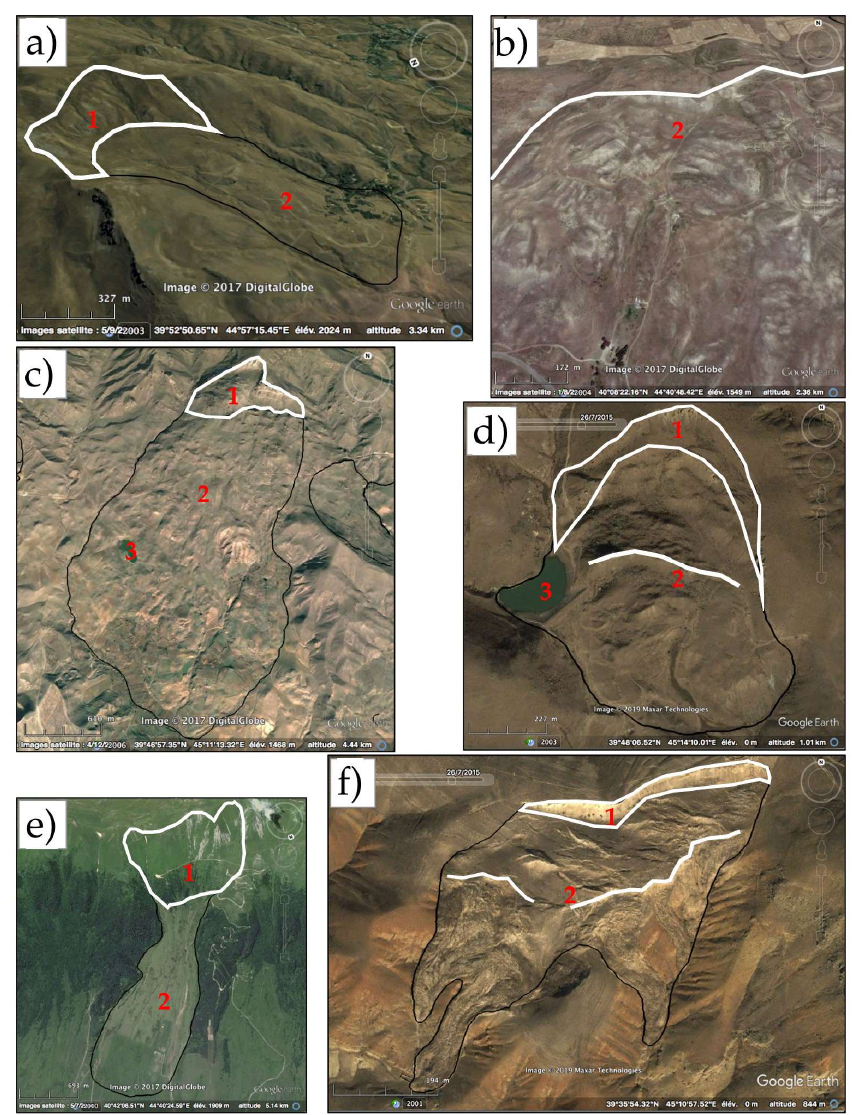
Figure 6. Examples of landslides identified in the present Matossian catalogue (based on data provided by DigitalGlobe and Google Earth ® ) representative of the criteria used to identify landslides. Landslide features are indicated as: 1, main scarp (outlined in white); 2, main landslide body (outlined in black, with secondary internal scarps indicated by white lines); and 3, lakes. ( a ) The Lanjanist landslide, showing a change of surface curvature. The landslide length (measured from the upper part of the scarp to the most distal part of the landslide body) is about 2 km. ( b ) The southern part of the Garni landslide, showing a secondary scarp and hummocky landforms in the mass deposit. Landslide length as shown, ~1 km (although the entire mass movement determined from Figure 5a reaches 2.5 km). ( c ) A landslide north of Rindr village, showing the presence of a main scarp, hummocky landforms, and a lake. Landslide length, ~3.5 km. ( d ) Aghavnadzor landslide dam, showing the main scarp, minor internal scarps, hummocky landforms, and a lake). Landslide length, ~1 km. ( e ) Margahovit landslide, showing a change of vegetation (the unvegetated area corresponds to the recent reactivation). Landslide length, ~4 km. ( f ) Khachik landslide, a recent landslide showing the main scarp with secondary internal scarps and transverse cracks. Landslide length, ~0.5 km.